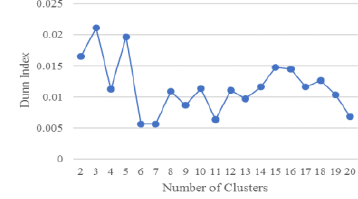
Figure 3. The Dunn index changes with the number of clusters obtained by Affinity Propagation algorithm